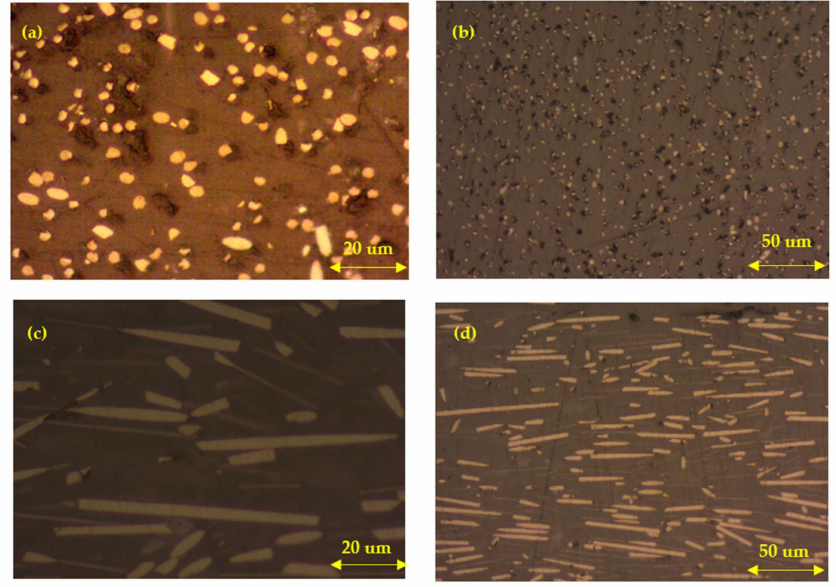
Figure 8. Sample micrographs of a polished specimen obtained from optical microscope: ( a ) Cross-section at 0 ◦ (printing direction), magnitude 50 × ; ( b ) cross-section at 0 ◦ , magnitude 20 × ; ( c ) cross-section at 90 ◦ , magnitude 50 × ; ( d ) cross-section at 90 ◦ , 20 ×